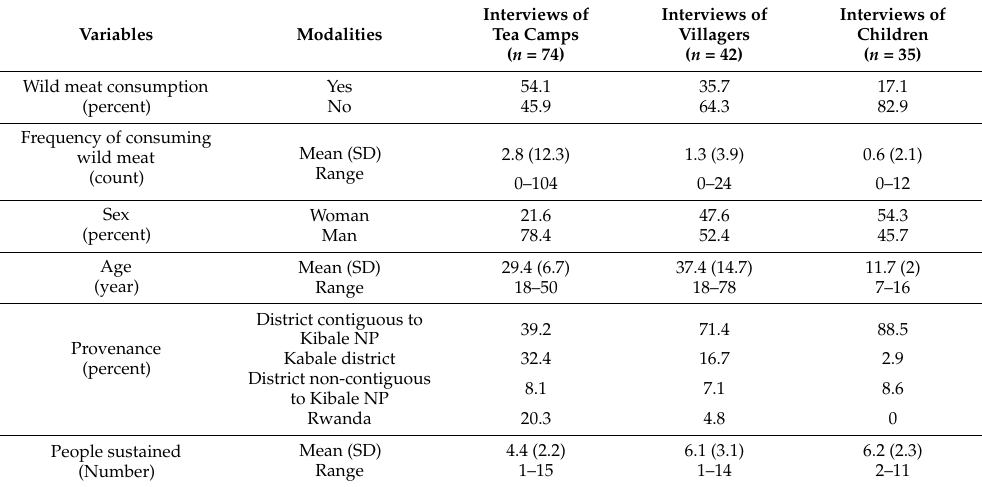
Table 2. Interview respondents’ description, Sebitoli area, Kibale National Park, Uganda.